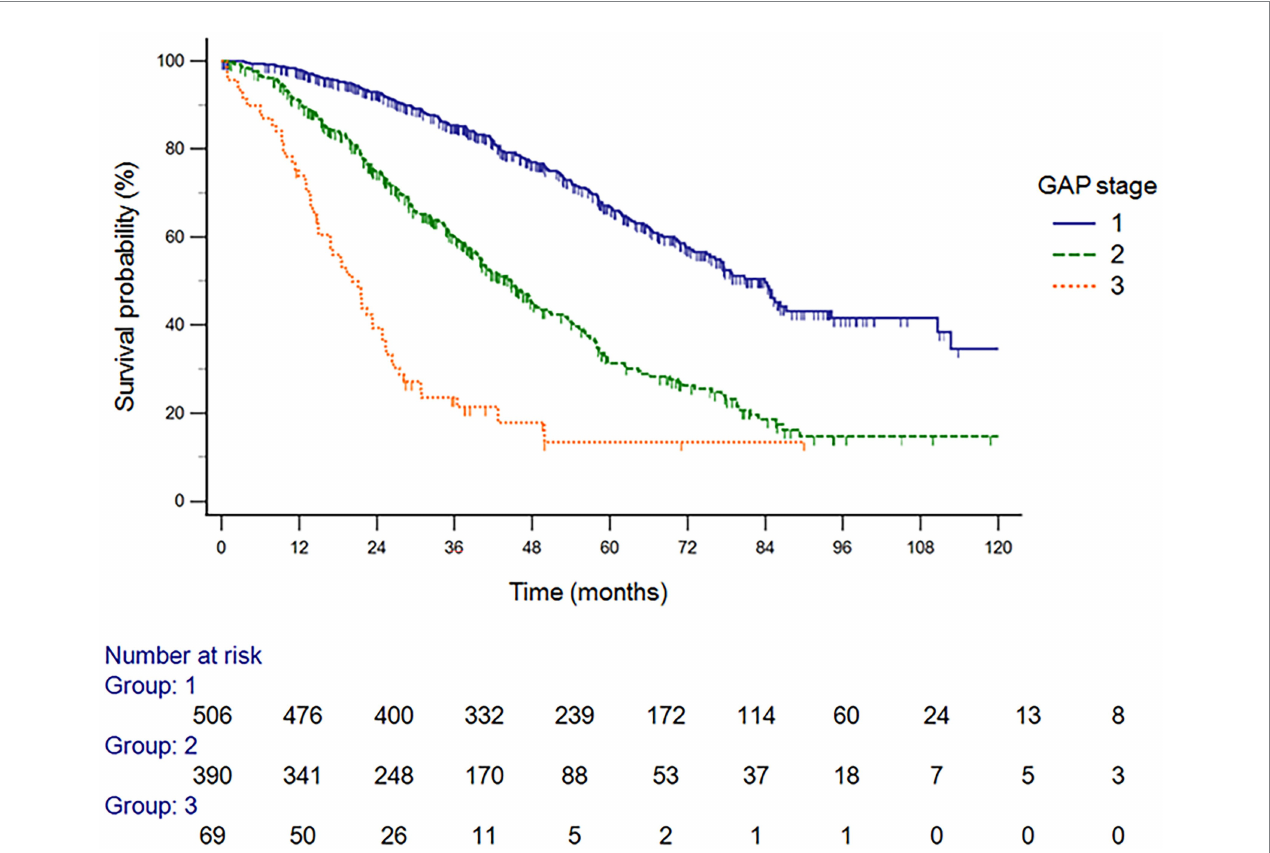
FIGURE 2 Survival probability analysis using Kaplan–Meier plotting, the 3-year mortality rates for the GAP stage I, II, and III groups GAP, gender, age, and physiology.